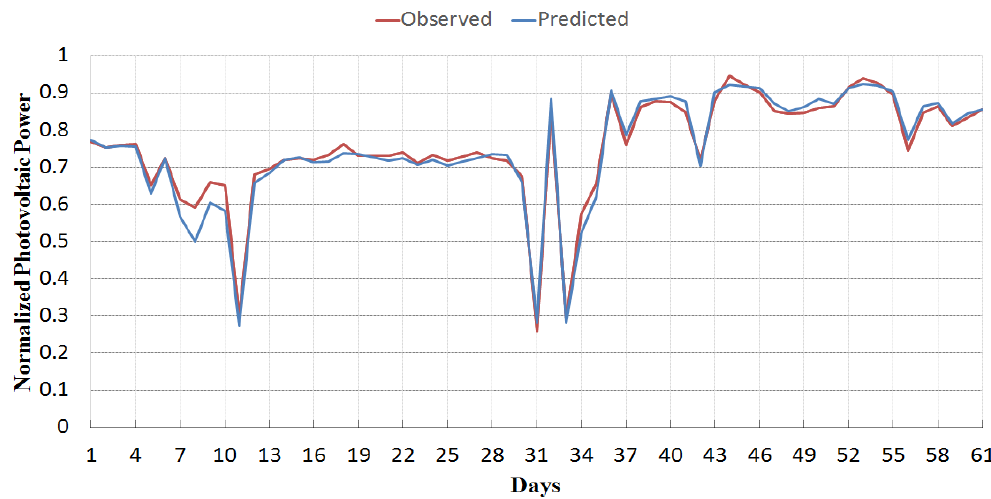
Figure 3. The predicted photovoltaic power values of the GWO-MLP method, which used T A , H R , SR TH and SR DH inputs. SR TH and SR DH inputs.